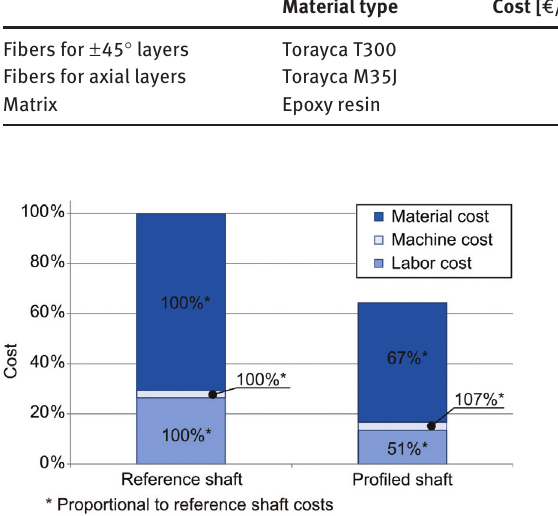
Figure 12 Summarized cost calculation results for reference cylin- drical and profiled shaft body.